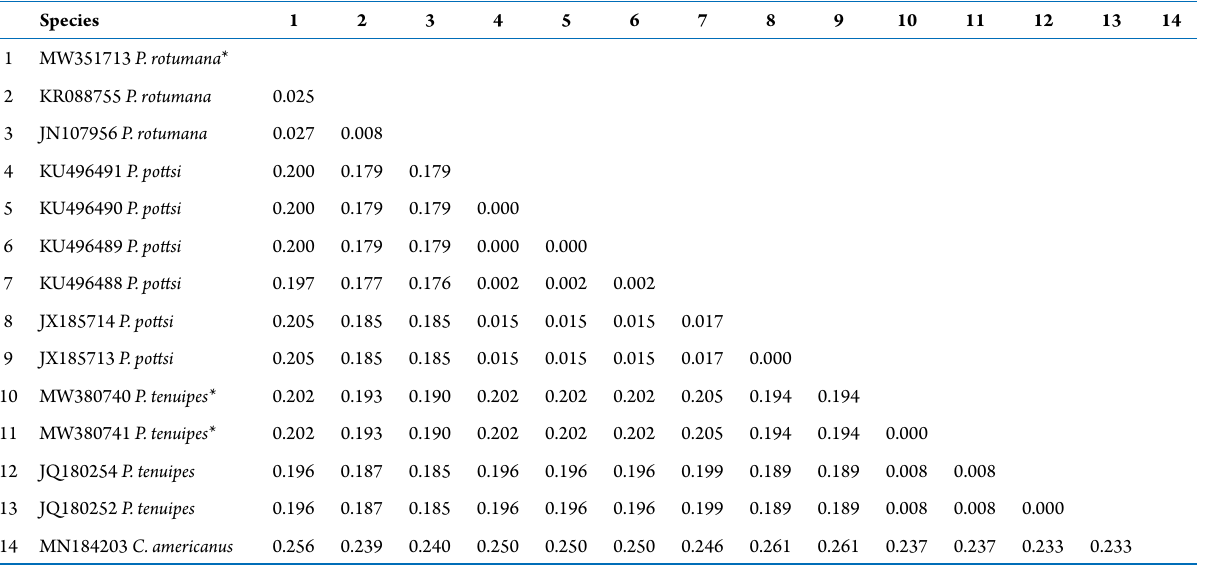
Table 2. Pairwise genetic analysis conducted using available COI gene sequences in GenBank with the present Indian materials of the genera Palaemonella and Cuapetes